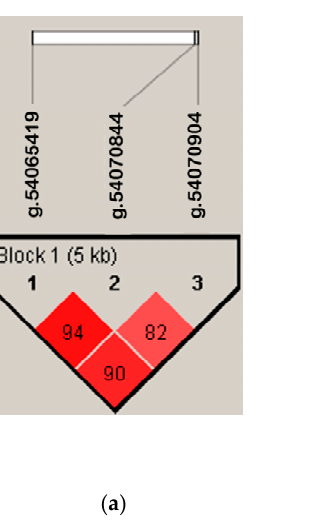
Figure 3. LD blocks of duck plumage color ( a ) and duck reproductive traits ( b ), consisting of g.54065419C>T, g.54070844C>T, and g.54070904C>T. Table 3. Haplotype analysis of duck plumage color and reproductive traits. Means of Haplotypes of Reproductive Traits and Egg Quality [g. 54065419 | g. 54070844 | g.